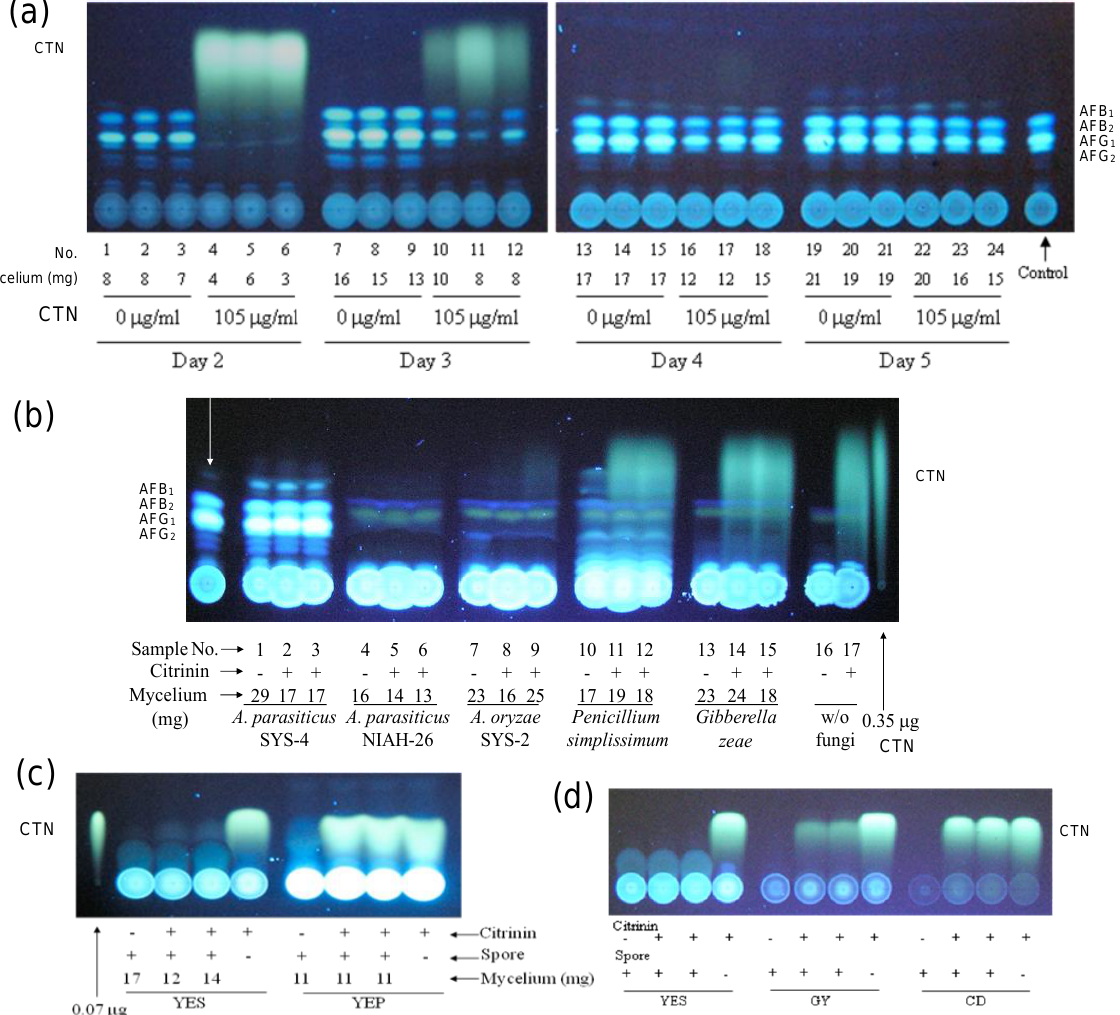
Figure 4. Disappearance of CTN fluorescence after incubation with various media: ( a ) A. parasiticus SYS-4 was cultured with 105 µ g mL − 1 of CTN in YES medium for 2–5 days, and the resulting culture media were analyzed by TLC, experiments were done in triplicate, developing solution 1 was used; ( b ) various species of fungi were cultured with CTN as in panel ( a ); ( c ) after A. parasiticus NIAH-26 was cultured with CTN in YES or YEP medium for 3 days by the tip culture method, the resulting medium was analyzed by TLC, mycelia weights are shown, developing solution 2 was used; ( d ) the same experiment as in panel (c) was done using YES, GY, or CD medium supplemented with CTN.